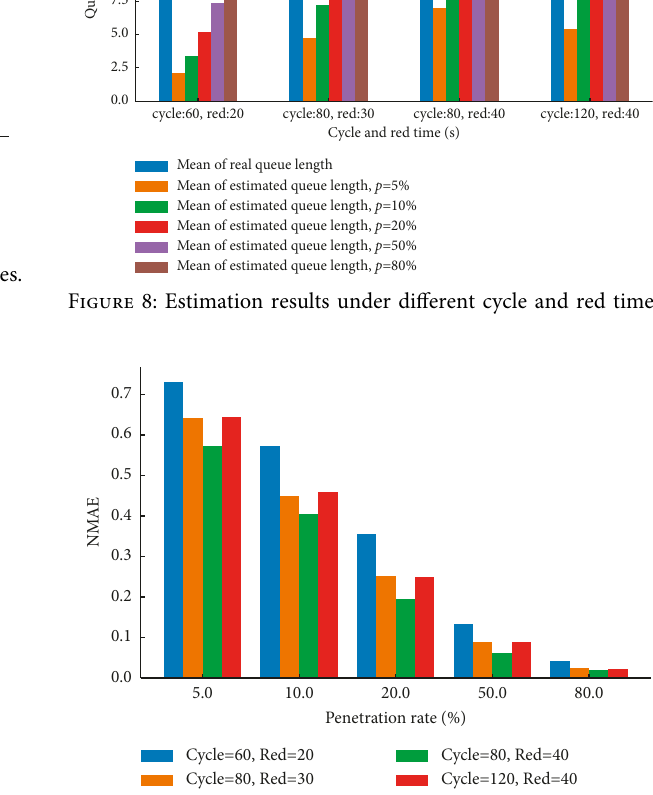
Figure 7: The relationship between the last CV in the queue and estimation error.